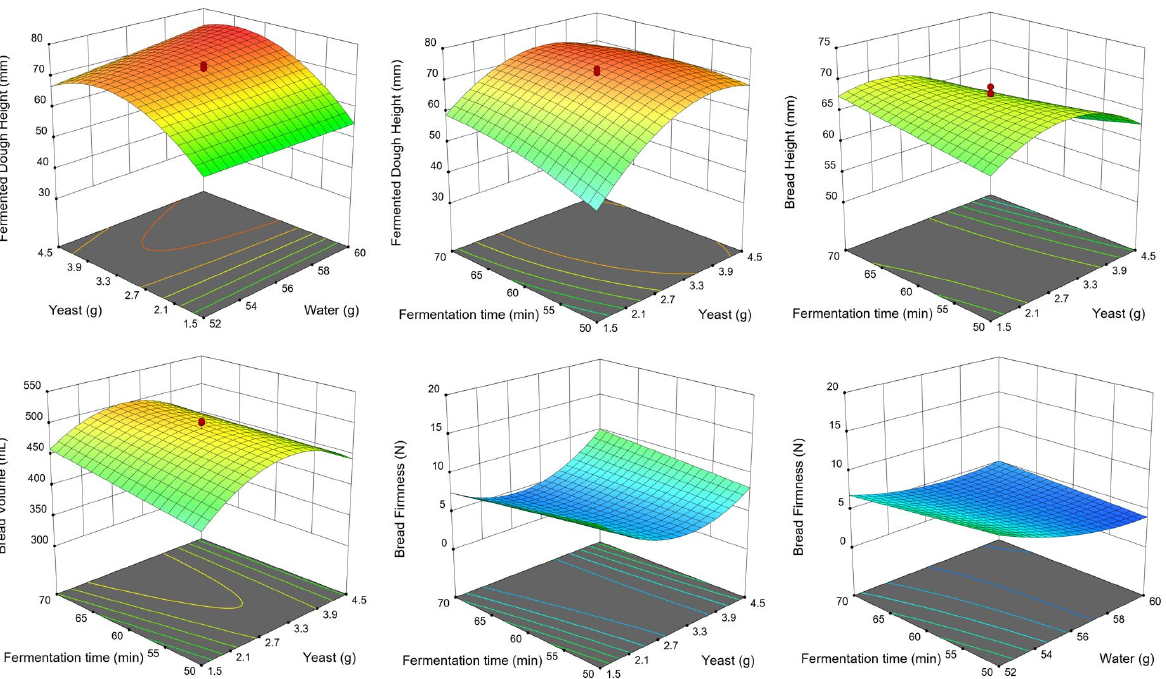
Figure 6. Response surface plots based on the reduced quadratic model developed for the fermented dough height, height, volume, and firmness of bread prepared with ‘O ‐ free’ flour. Among the four factors set up in the experiment, fermentation time itself had no sig ‐ nificant effect on the representative attributes of bread quality, such as bread volume, height, and firmness. However, the interaction between yeast and fermentation affected bread quality significantly. Furthermore, the water, yeast, and mixing time appeared to affect the quality. As the major quality parameter of bread, the maximum value of bread height and volume and the minimum value of bread firmness were set to identify the optimum conditions based on desirability. The optimized conditions were as follows: 60 g of water, 2.6 g of yeast, 2.5 min mixing time, and 70 min fermentation time. To validate the predicted value, one of the optimized solutions suggested by the Design Expert pro ‐ gram was used to prepare bread and compare it with bread made at the center point (Ta ‐ ble 6). The bread made with ‘O ‐ free’ flour had a higher height, a larger volume, and a greater firmness than the predicted values. In addition, a significant improvement was observed compared to bread prepared with a center point (Figure 7). Overall, the quality of bread made with ‘O ‐ free’ flour was significantly improved by optimizing formula and processing conditions.